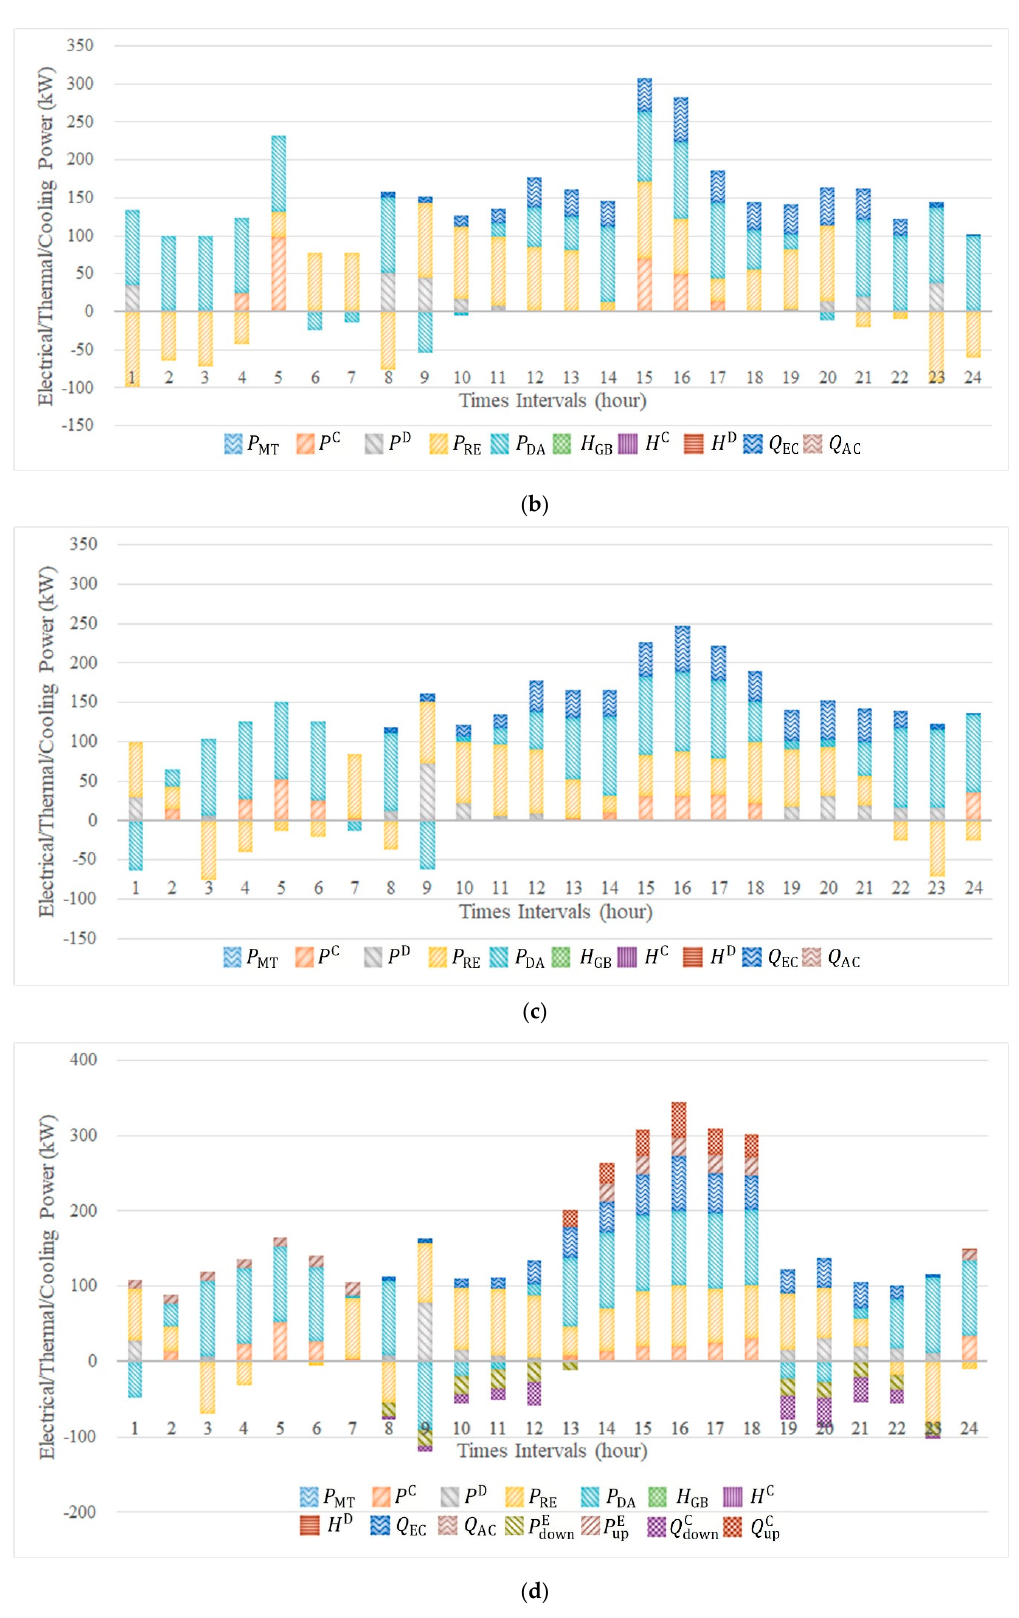
Figure 6. ( a ) The optimal operation results in Case 1 on the typical summer day; ( b ) The optimal operation results in Case 2 on the typical summer day; ( c ) The optimal operation results in Case 3 on the typical summer day; ( d ) The optimal operation results in Case 4 on the typical summer day. Note: P E and Q C stand for values of electrical and cooling loads shifted down, respectively. As the down down electrical and cooling loads are positive values in Figure A7 etc. in Appendix B, values of P E Q C are set to be negative ones in Figure 6 for the purpose of clear down